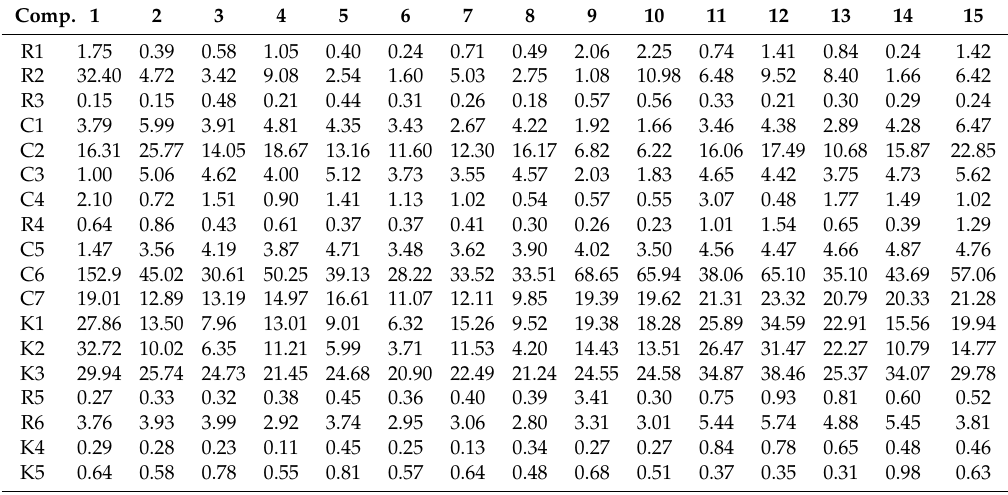
Table 5. The content results of the 18 target compounds calculated by external standard method